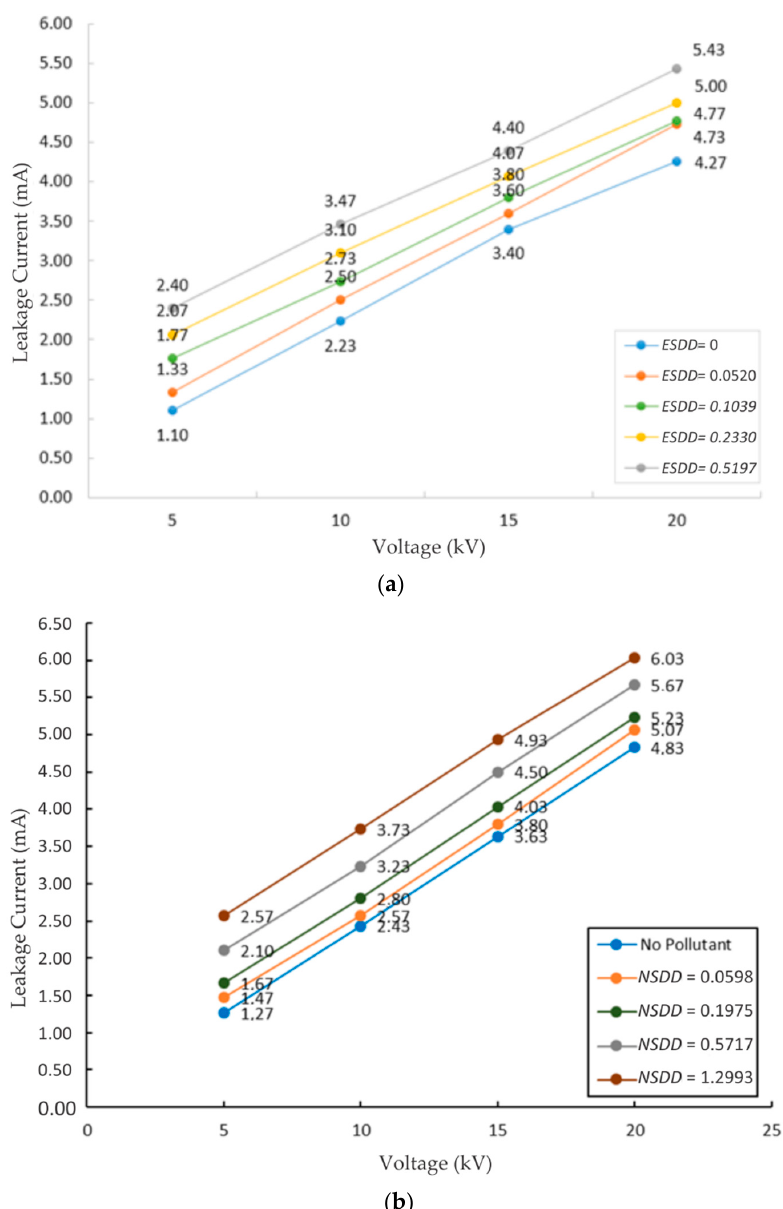
Figure 19. Effect of changes in voltage on leakage current in insulator polymer with ( a ) salt contaminant and ( b ) fly ash contaminant.